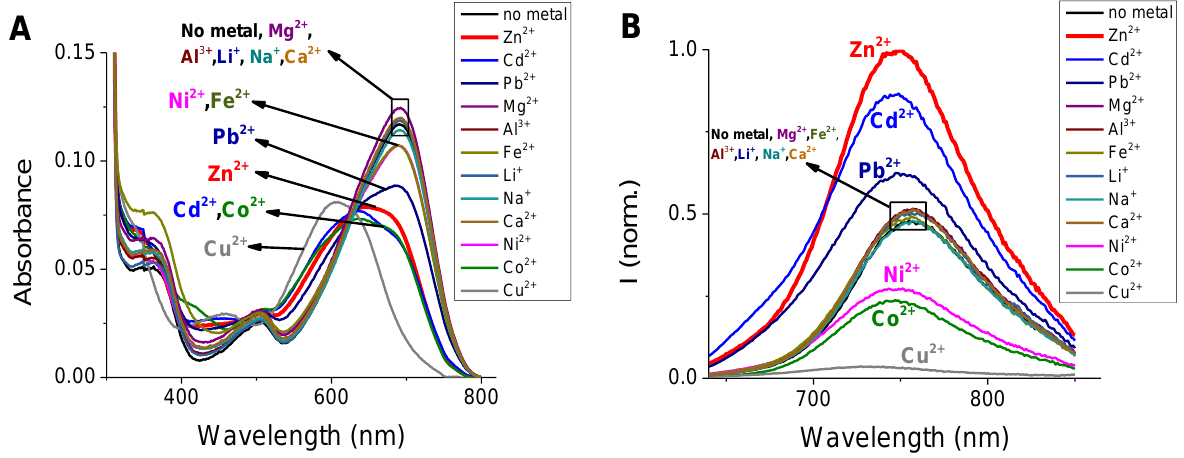
Figure 5. ( A ) UV-Vis absorption spectra and ( B ) emission spectra of 1 (5 µ M), in the presence of different metal cations (10 µ M). Conditions: MeOH:MOPS 10 mM pH7 (50:50); λ exc = 620 nm.